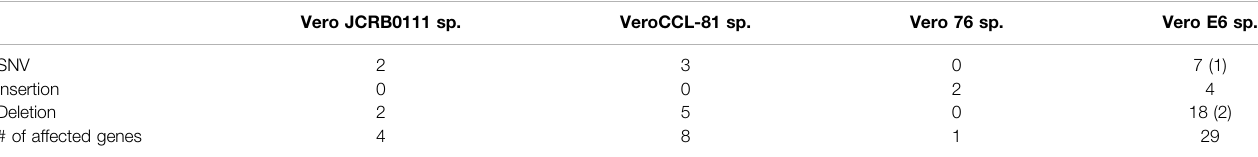
TABLE 2 | Subline-speci fi c LOF variants in genes related to viral infection/proliferation. Vero JCRB0111